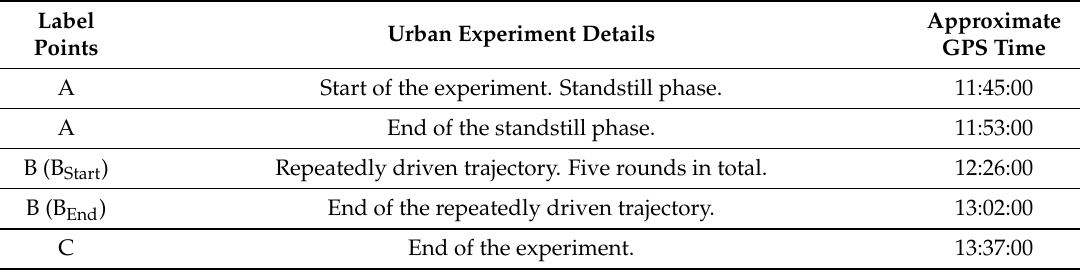
Table 1. Details of marked points on the urban trajectory